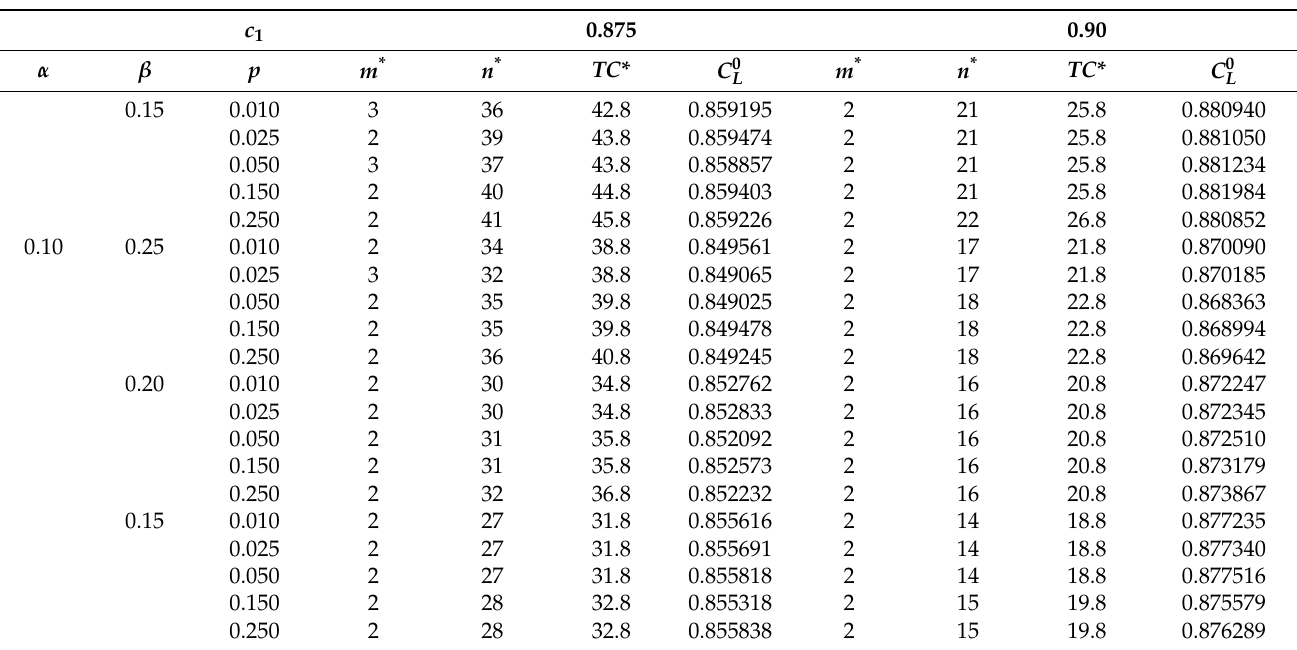
Table A3. The optimal ( m *, t *), n *, total cost TC** and the critical value for c 1 = 0.825,0.85 and p =